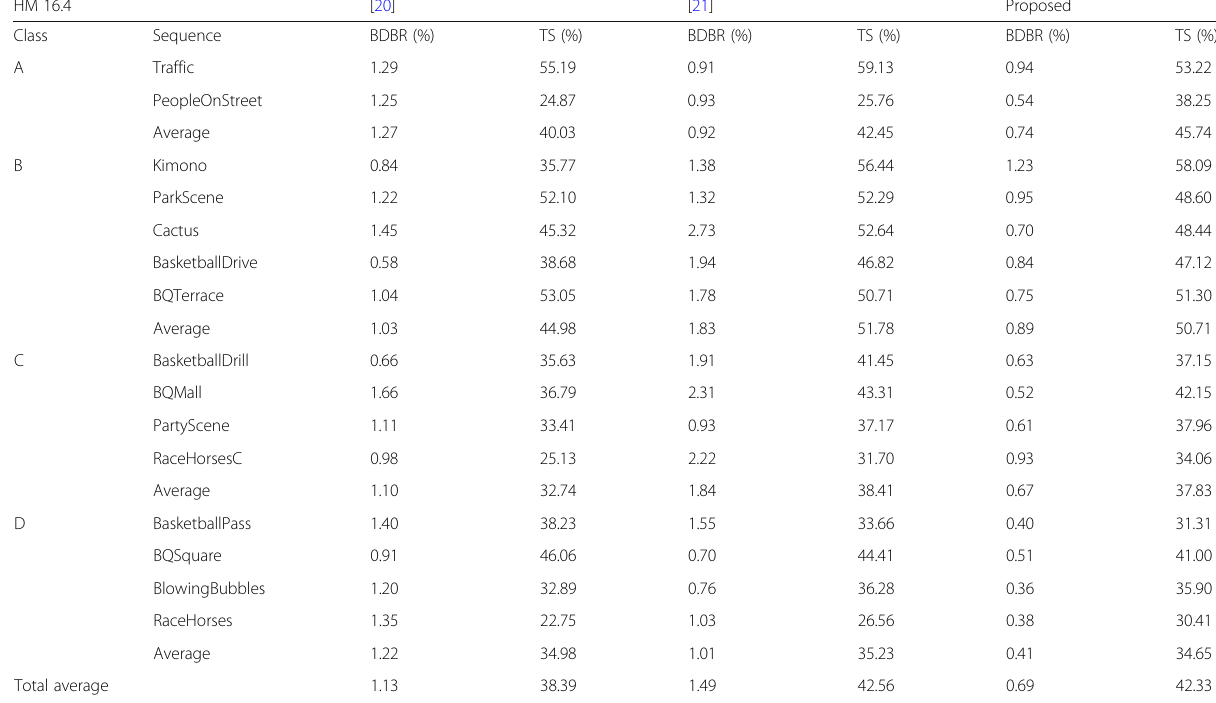
Table 5 Performance comparison with [20, 21] under random-access configuration HM